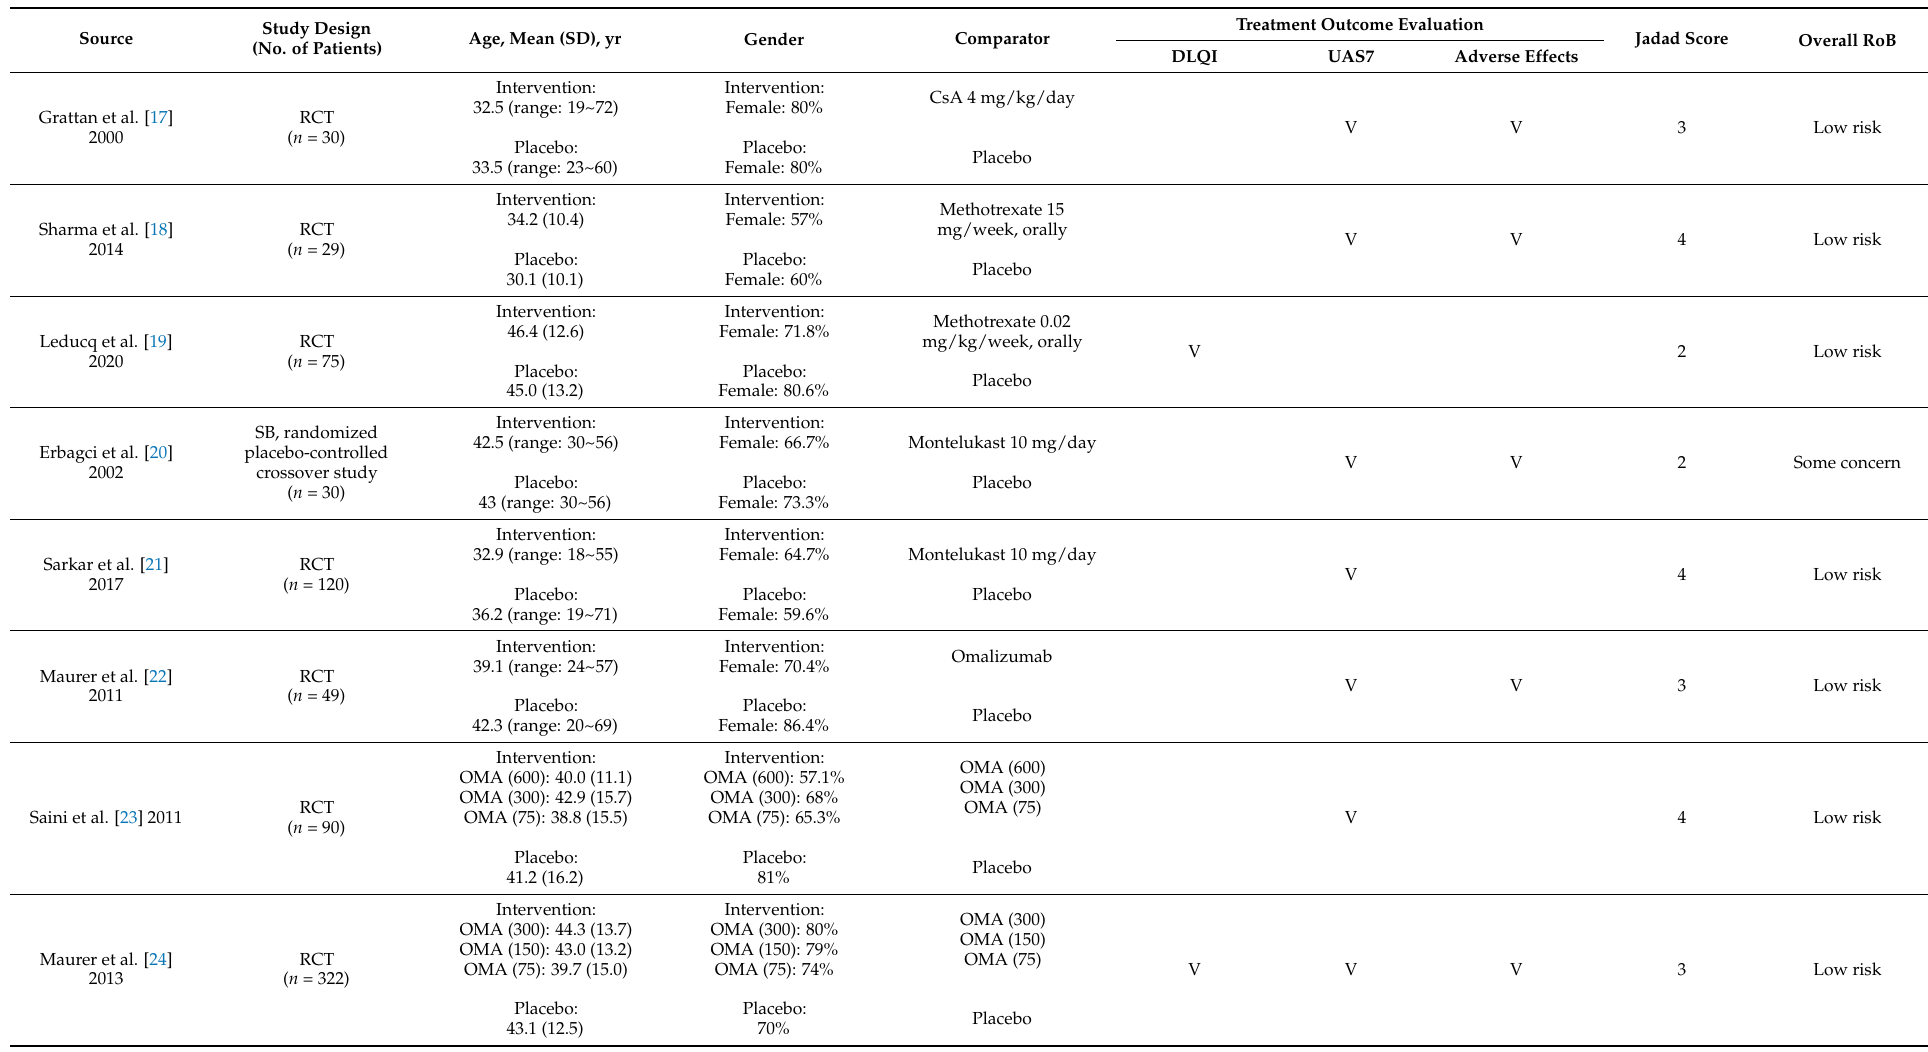
Table 1. Characteristics of included